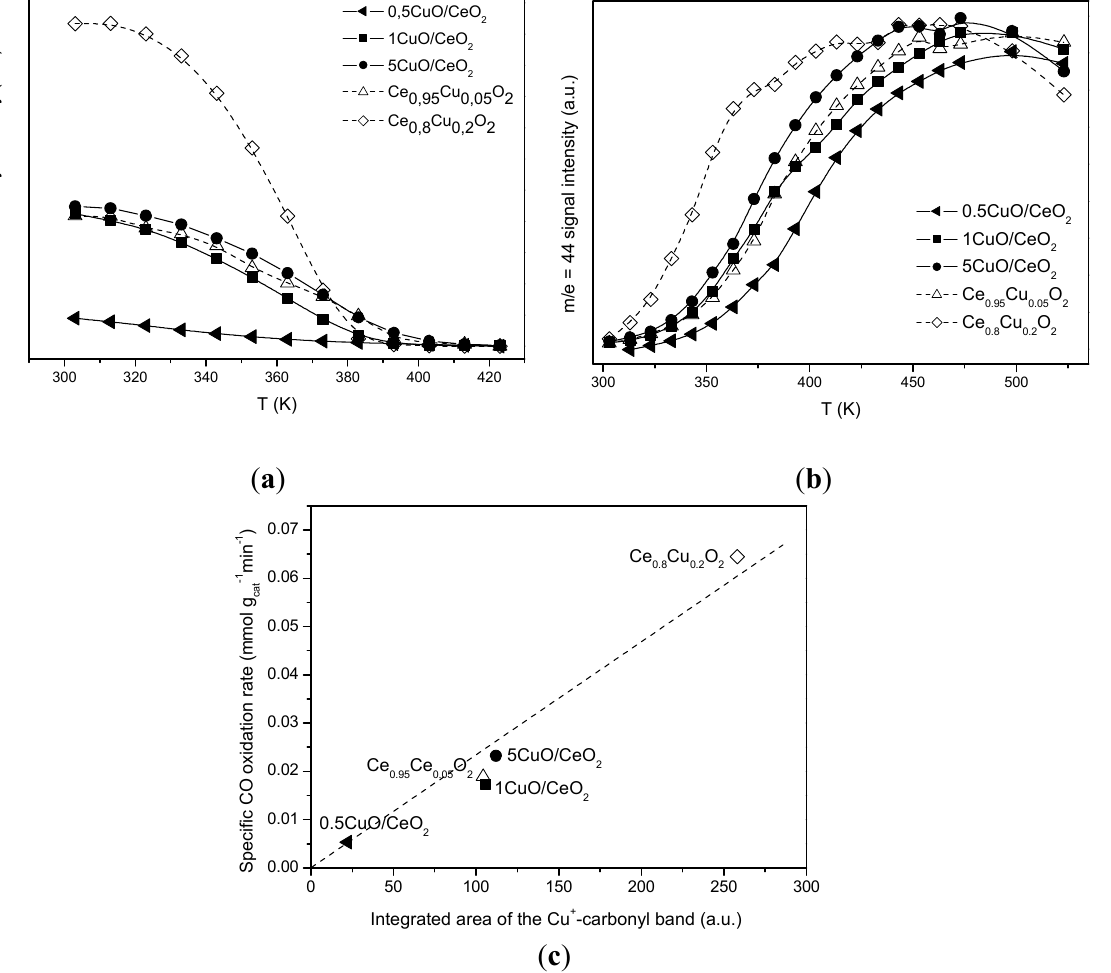
Figure 7. ( a ) intensity of the Cu + -carbonyl as a function of the reaction temperature under CO-H -O mixture for the indicated catalysts. ( b ) Intensity of the 2 2 QMS m / e = 44 signal, corresponding to CO , during the tests performed with the DRIFTS 2 cell under CO-H -O mixture. ( c ) correlation between the intensity of the 2 2 Cu + -carbonyl just prior to CO oxidation onset and the initial CO oxidation